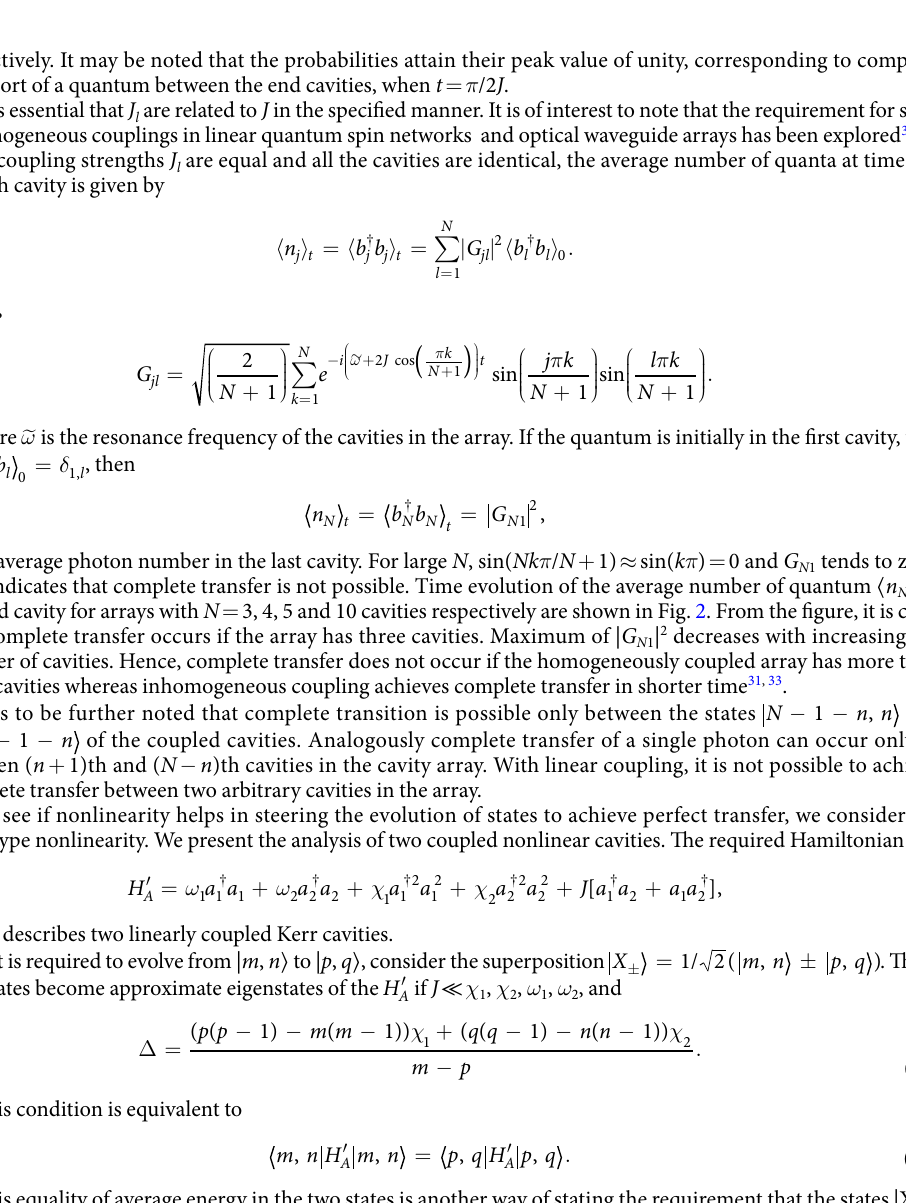
Figure 2. Average number of photon in the end cavity as a function of t in cavity array. Number of cavities in the array is N = 3 (solid line), 4 (dashed), 5 (dotted) and 10 (dot-dashed). All the cavities are identical and homogeneously coupled with coupling strength = J 2/10 . The system parameters are normalized in the unit of ω 